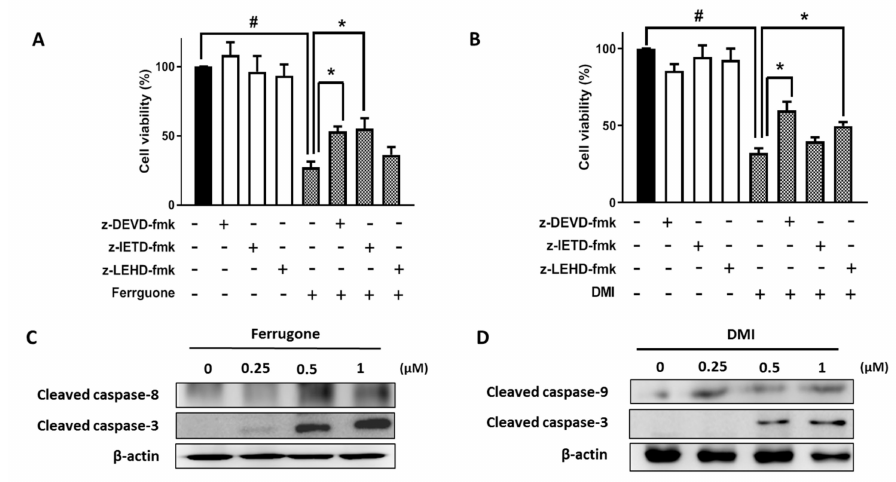
Figure 4. Involvement of caspase-3, -8, and -9 in ferrugone and DMI-induced cell death in human ovarian cancer cells. ( A , B ) A2780 cells were pretreated with caspase-3 inhibitor z-DEVD-fmk (75 µ M), caspase-8 inhibitor z-IETD-fmk (50 µ M), and caspase-9 inhibitor z-LEHD-fmk (75 µ M) for 2 h, and then treated with ferrugone ( A ) and DMI ( B ) (0.5 µ M) for 24 h. MTT assay was performed to determine cell death. ( C , D ) A2780 cells were treated with ferrugone ( C ) and DMI ( B ) (0.25, 0.5, and 1 µ M) for 48 h. Cleaved caspase-3 and caspase-8 levels were determined by Western blot assay. β -actin was used as an internal control. The data are representative of three independent experiments. Student’s t -test (two-tailed) was applied to evaluate the significance. # p < 0.05 as compared with the untreated group. * p < 0.05 as compared with the ferrugone or DMI only-treated